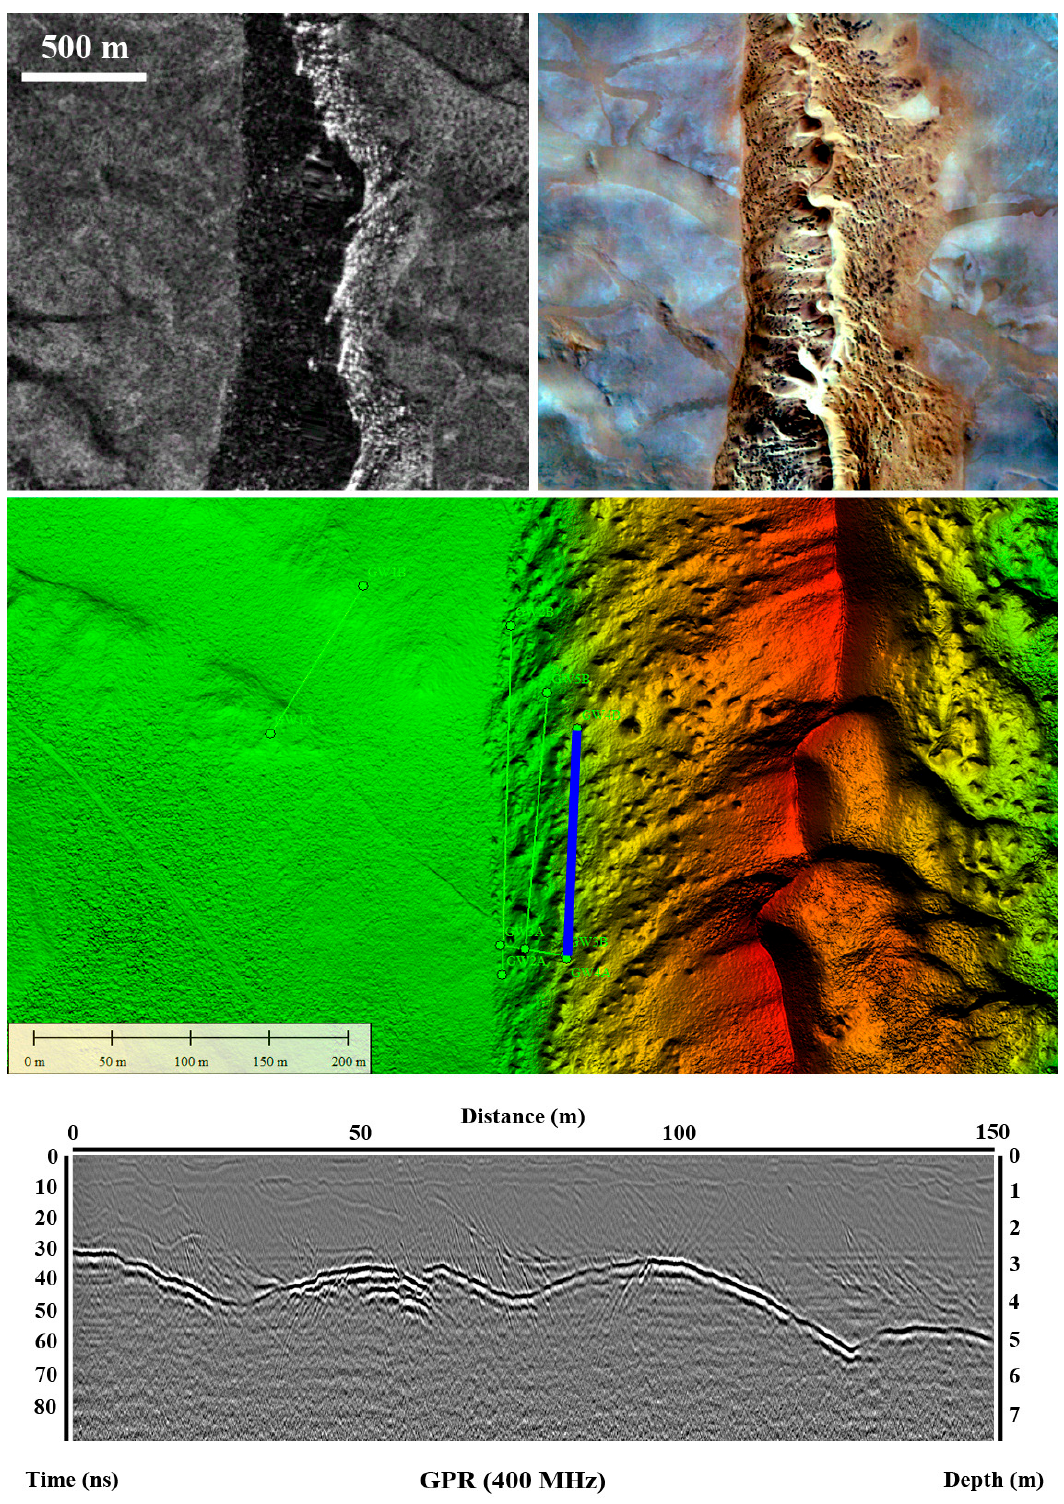
Figure 7. ( Top ): PALSAR-2 image of the northern part of the Warsaw dune ( left ) and drone-generated mosaic of the same area, with image contrast enhanced ( right ). Middle: Drone-generated DEM of the central part of the Warsaw dune, with GPR profiles location. ( Bottom ): GW5 ground-penetrating profile acquired at 400 MHz (depth scale was computed using a dielectric constant ε = 3), showing the subsurface paleochannel under 5 m of dune’s sand.